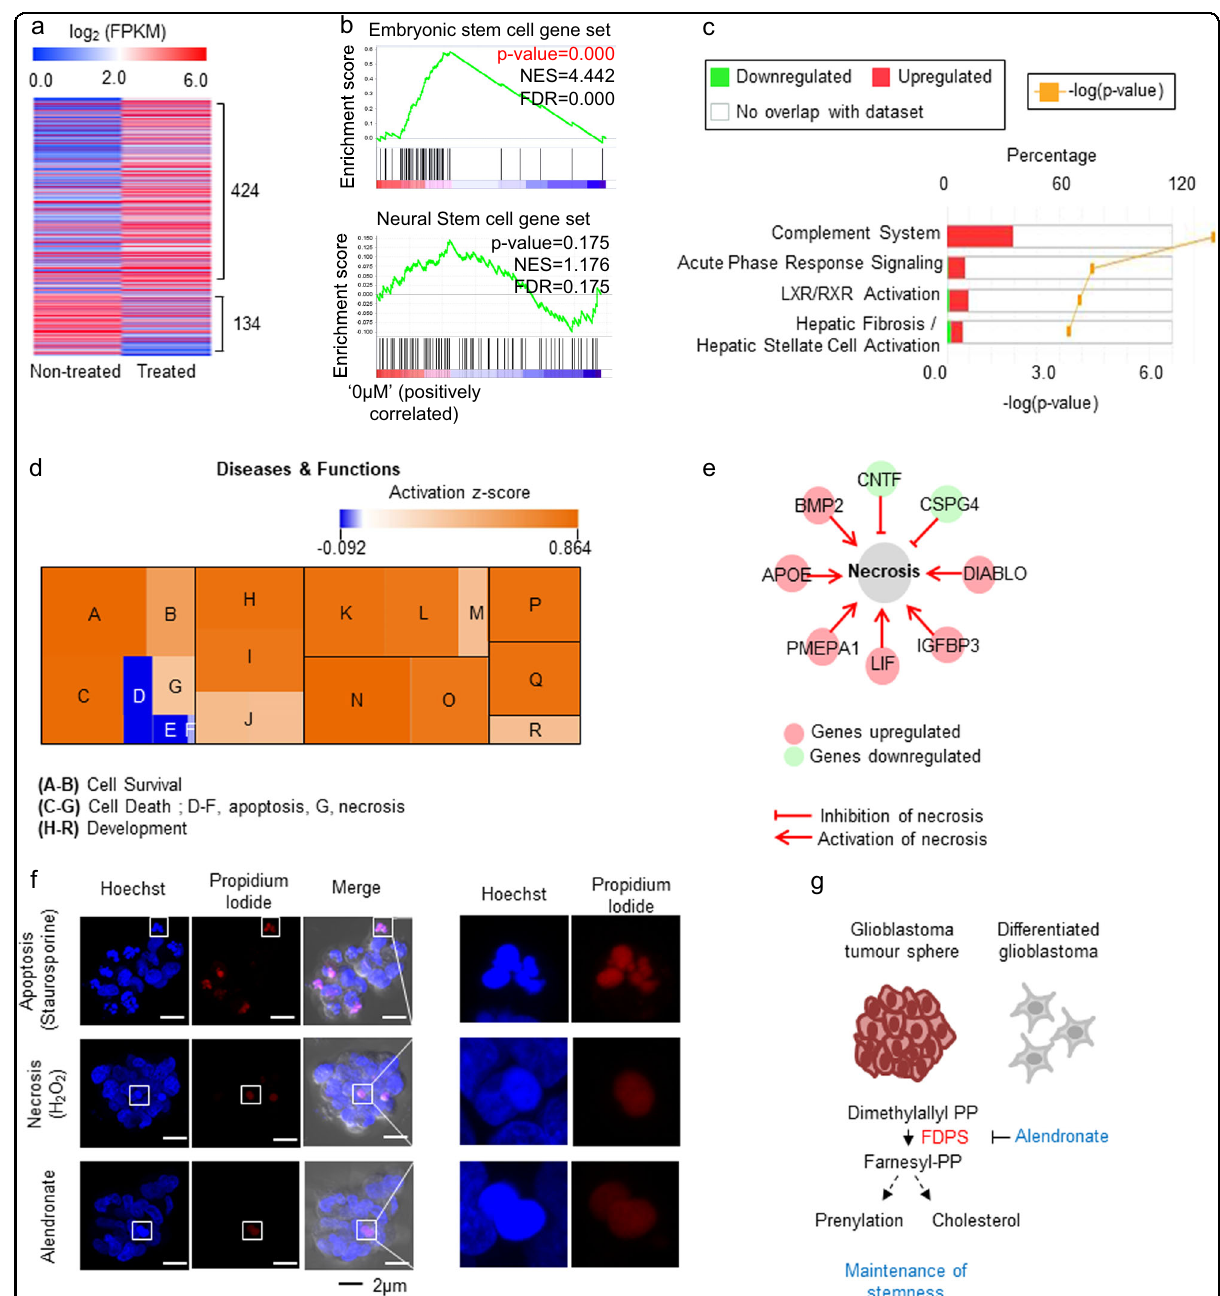
Fig. 5 Alendronate reduces the embryonic stem cell signature and activates necrosis in glioblastoma spheres. a DEGs between TS13-20 cells treated with or without alendronate (10 μ M) for 7 days were analyzed by RNA sequencing. Genes with expression changes greater than two-fold are shown. DEGs are listed in Supplementary Table S3. b GSEA showed that embryonic stem cell gene signatures were downregulated in alendronate-treated cells. c , d DEGs were analyzed by core analysis using Ingenuity ® Pathway Analysis (IPA). c Canonical pathway analysis showed that the most functionally in fl uenced mechanistic network was the complement system. d Downstream effect analysis showed that necrosis- and development-related genes were activated by treatment with alendronate in the disease and functions category. A: cell viability of neurons, B: cell viability, C: neuronal cell death, D – F: apoptosis, G: necrosis, H-J: cellular development, K-M: tissue development, N – O: nervous system development and function, P: embryonic development, Q: organismal development, R: connective tissue development and function. e The network of necrosis-related DEGs induced by treatment with alendronate is shown. f Alendronate caused necrosis-related cell death. TS13-20 cells were treated with staurosporine (0.5 μ M, 18h), hydrogen peroxide (1 mM. 18h), or alendronate (10 μ M, 3 days) and then stained with Hoechst and propidium iodide. Z-stack orthogonal projection images were obtained with an LSM780 confocal microscope and processed using ZEN 2012 analysis software (Carl Zeiss, Germany). g A model linking FDPS with glioblastoma stemness. Glioblastoma TS cells rely on FDPS for maintenance of stemness, and alendronate is a potential candidate drug for glioblastoma